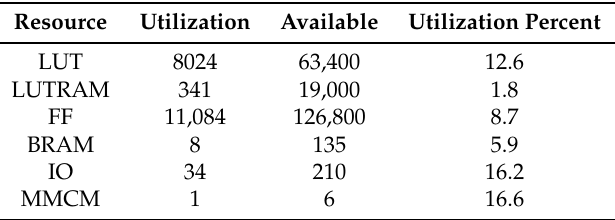
Table 1. Power unit occupation.